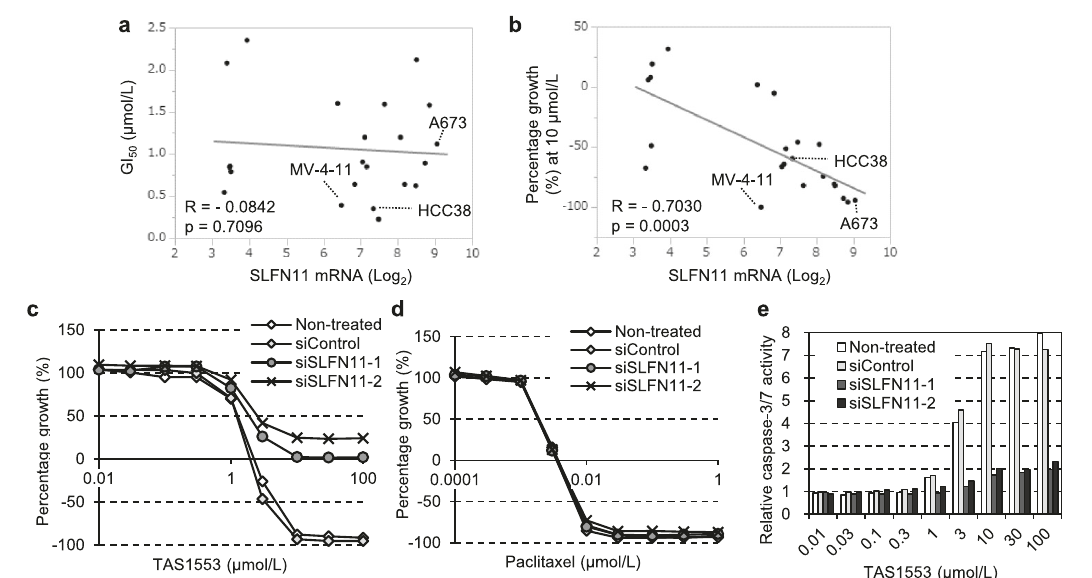
Fig. 3 Involvement of SLFN11 in apoptosis induction by TAS1553. a Scatterplot indicating the correlation between SLFN11 expression and TAS1553 GI 50 in 22 cell lines. b Scatterplot idicating the correlation between SLFN11 expression and percentage cell growth (%) at 10 µ mol/L of TAS1553 in the same cell lines as mentioned in a . c , d Effects of TAS1553 ( c ) and paclitaxel ( d ) on the proliferation of A673 cells treated with siRNA against SLFN11. The cells were treated with the test compound for 72 h 2 days after treatment with each siRNA. e Caspase3/7 activation by TAS1553 in A673 cells treated with siRNA against